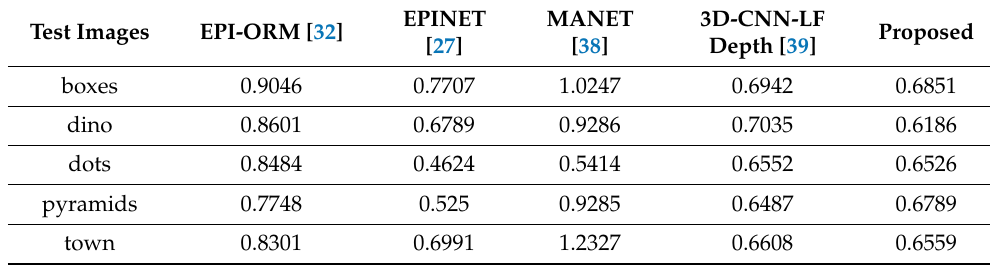
Table 1. Comparison RMSE * between the state-of-the-art networks and the proposed model. Test Images